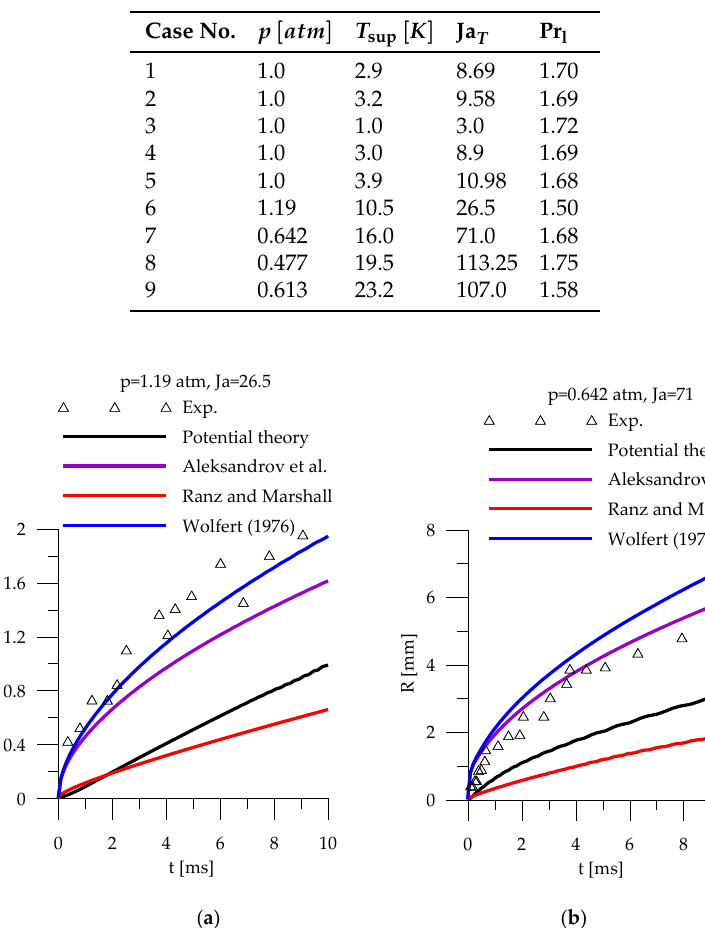
Table 2. Summary of test cases used for validation.